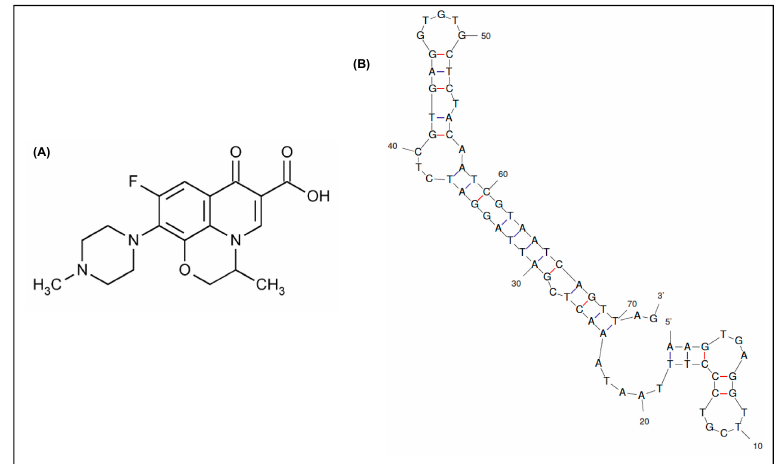
Figure 1. ( A ) Chemical structure of ofloxacin. ( B ) 2-D structure of the truncated DNA aptamer modeled by Mfold web server [27] ( ∆ G = − 24.36 kcal/mol).